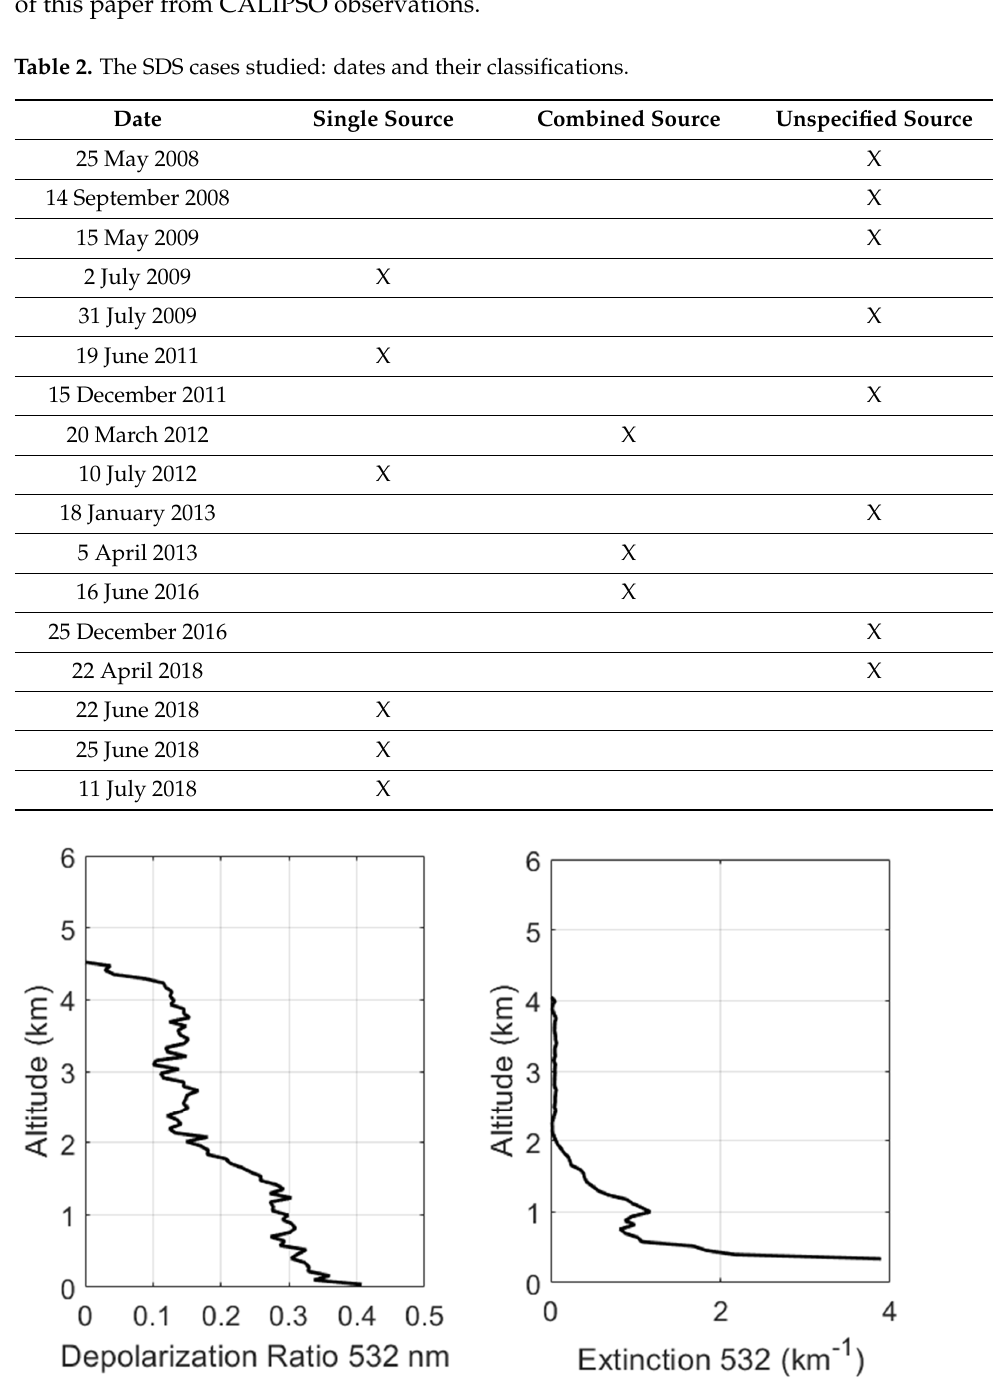
Figure 3. Depolarization and extinction profiles of the SDS on 2 July 2009 corresponding to the im- age in Figure